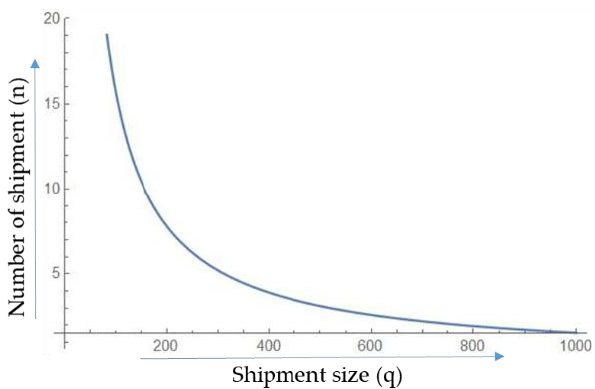
Figure 10. Impact of changing shipment size on optimal number of shipments.